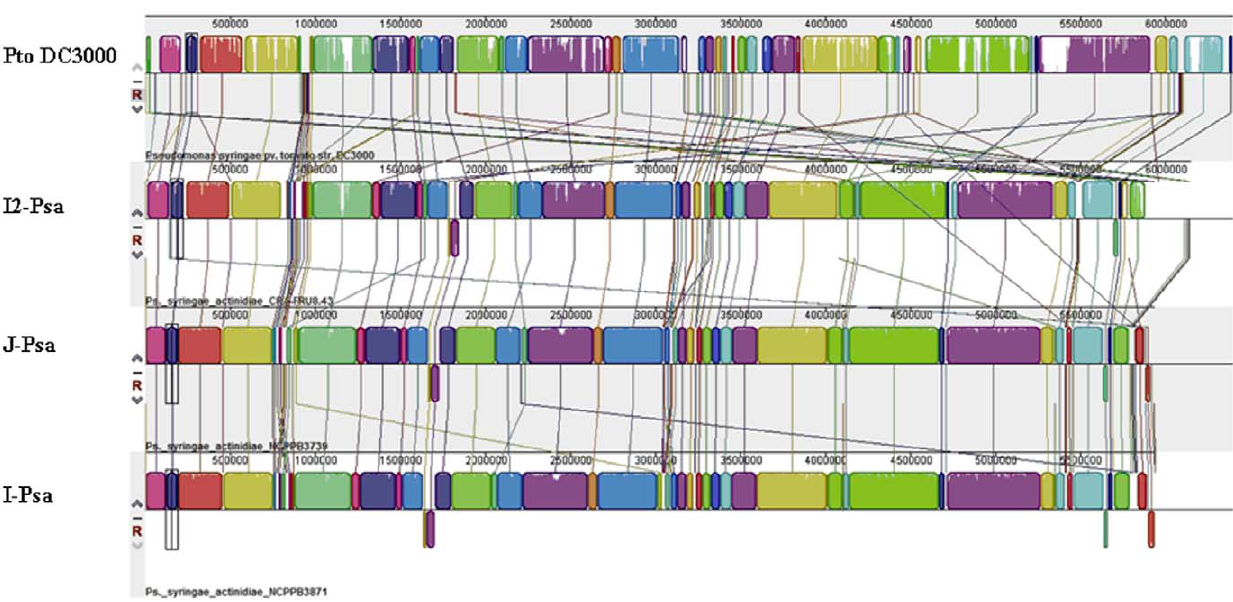
Figure 2. Pairwise alignment between the draft genomes of J- Psa , I- Psa and I2- Psa and the complete genome of P. s . pv. tomato DC3000 using the MAUVE software. Colored blocks outline genome sequence that align to part of another genome, and is presumably homologous and internally free from genomic rearrangement (Locally Colinear Blocks or LCBs). Areas that are completely white were not aligned and probably contain sequence elements specific to a particular genome. Blocks below the centre line indicate regions that align in the reverse complement (inverse) orientation. A profile is drawn within each LCB with the height of the color corresponding to the average degree of sequence conservation.